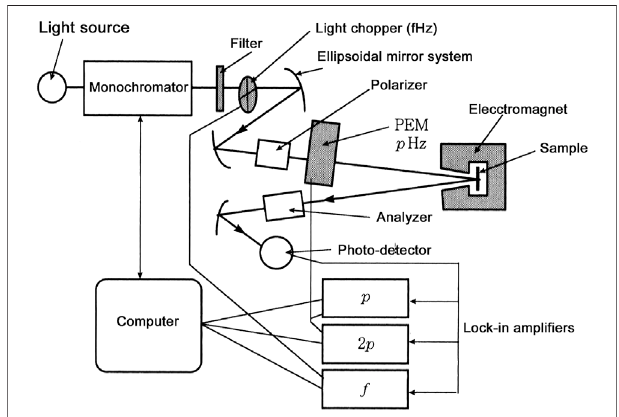
FIGURE 13 | Spectroscopic measurement setup for polar magneto- opticalKerreffect forwidespectral regionfromnear-ultraviolettonearinfrared region.